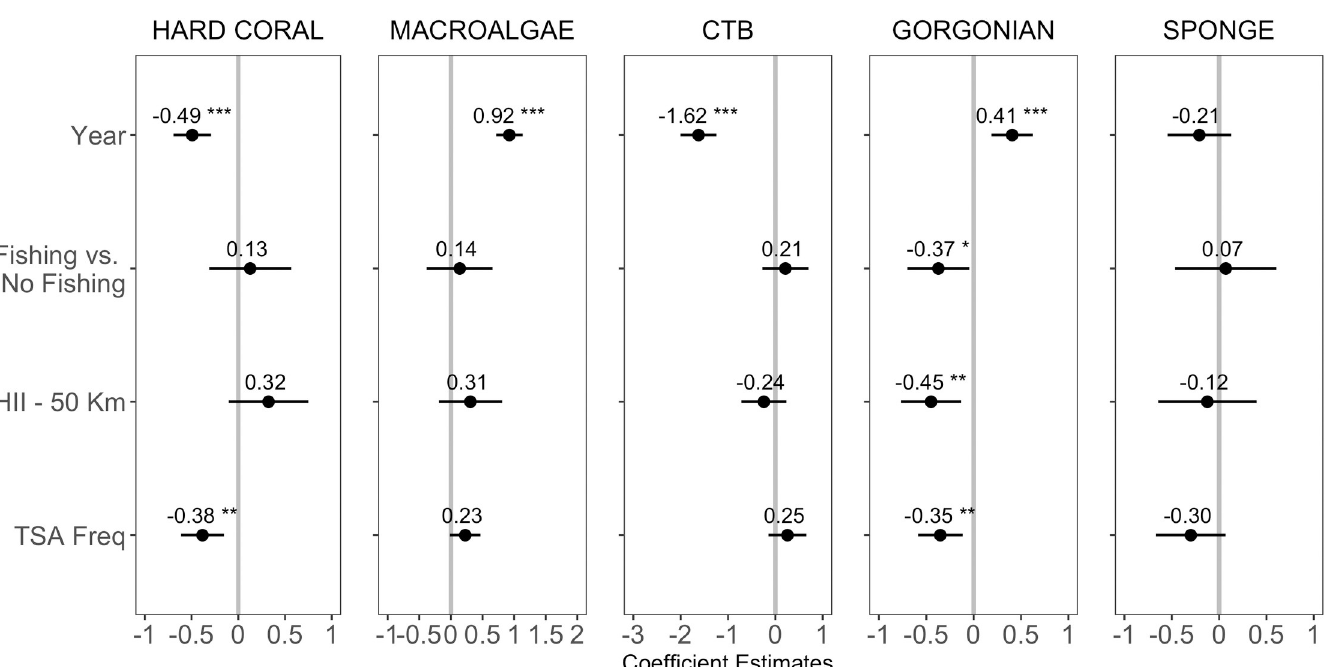
Fig 3. Effect-sizes ( ± 95% CI) of covariates from the Bayesian generalized linear mixed-effect model on the five benthic groups. Values above points are effect sizes. CIs crossing the vertical grey line represent non-significant effects. Significance levels: ��� = 0.001; �� = 0.01; � = 0.05.